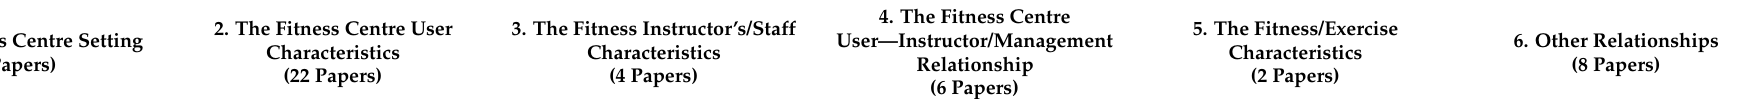
Table 5. Barriers to exercising for adults without physical disabilities (AwoPD) distributed across the six modified context factor categories. Numbers in parentheses in the coloured cells refer to the total number of different papers (references in the square brackets) informing each of the six